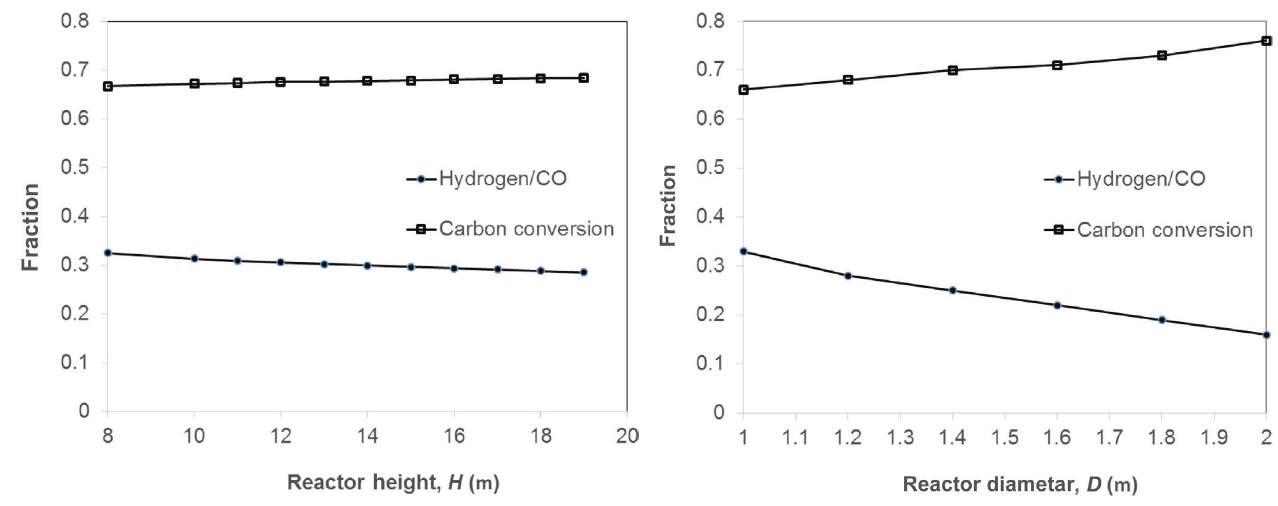
Fig. 4 – Effect of reactor height on syngas quality and car- bon conversion